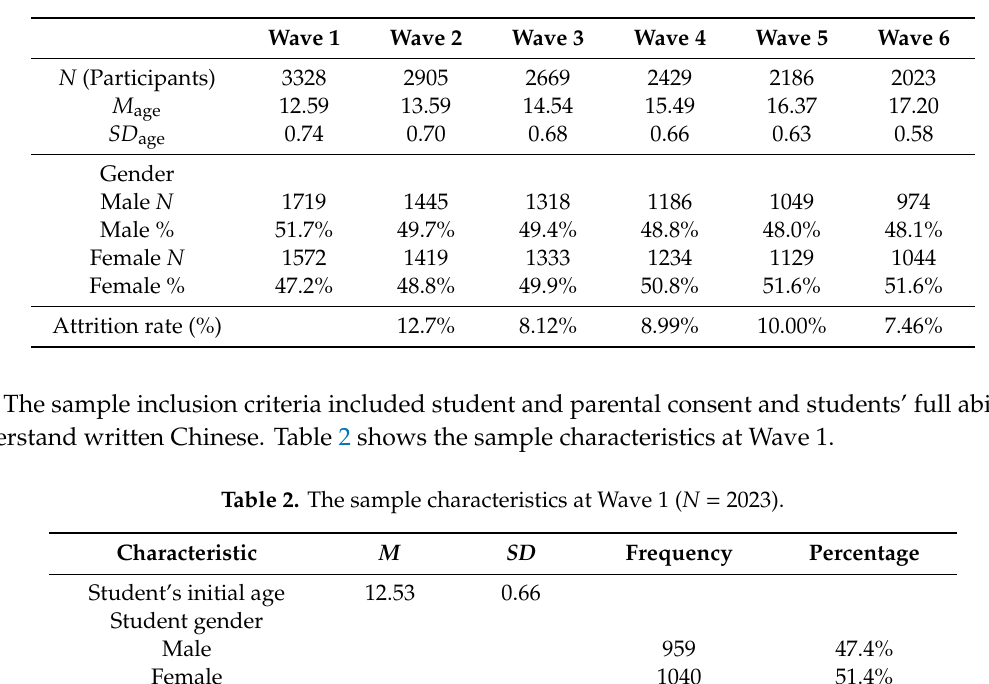
Table 1. The sample characteristics and sample size at each wave.